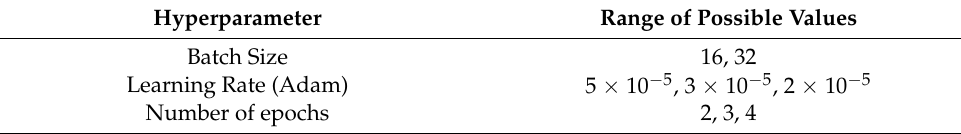
Table 2. BERT fine-tuning